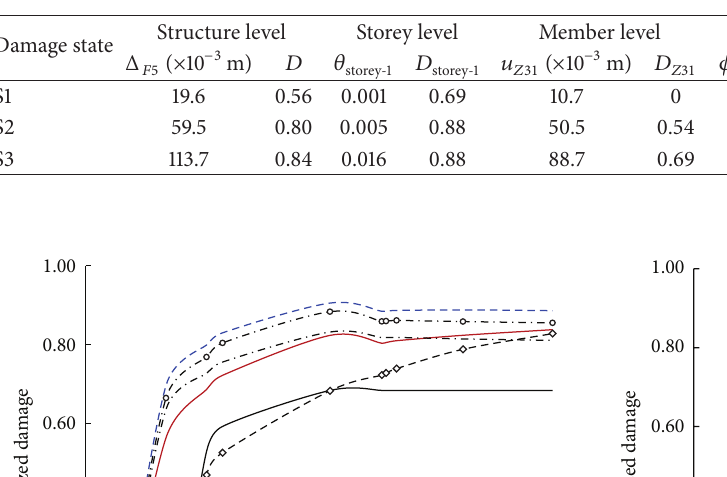
Table 3: The values of damage indicators and generalized damage at different level.